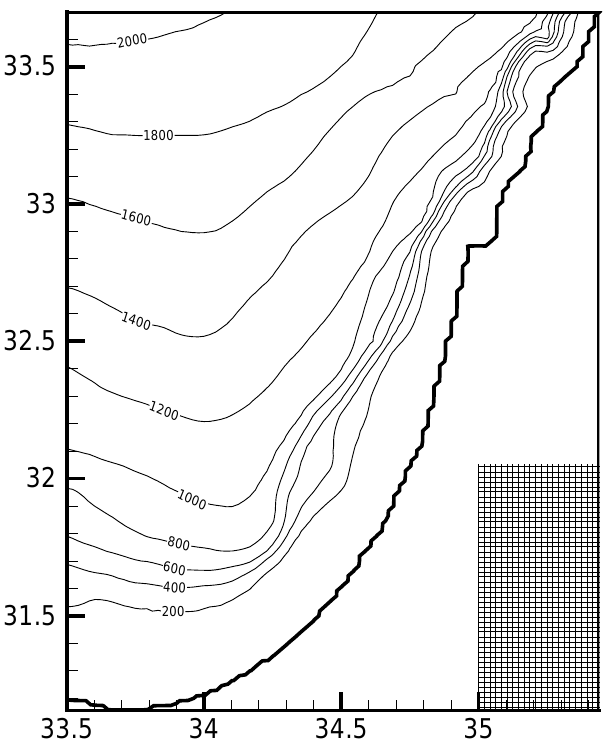
Fig. 1. Model domain showing the bathymetry and a portion of the